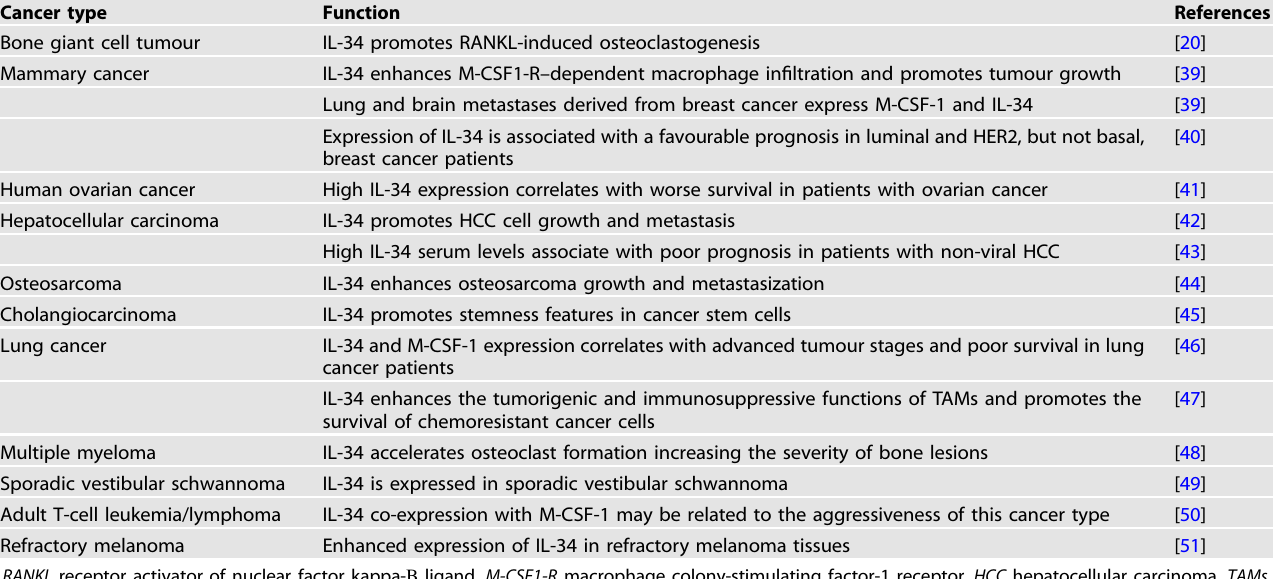
Table 2. Role of IL-34 in different cancer